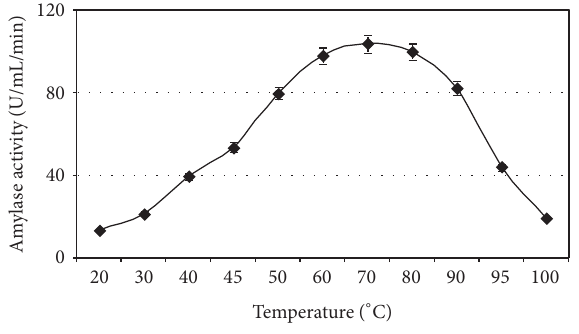
F 4: Temperature pro�le for the puri�ed produced by Bacillus licheniformis AI20.